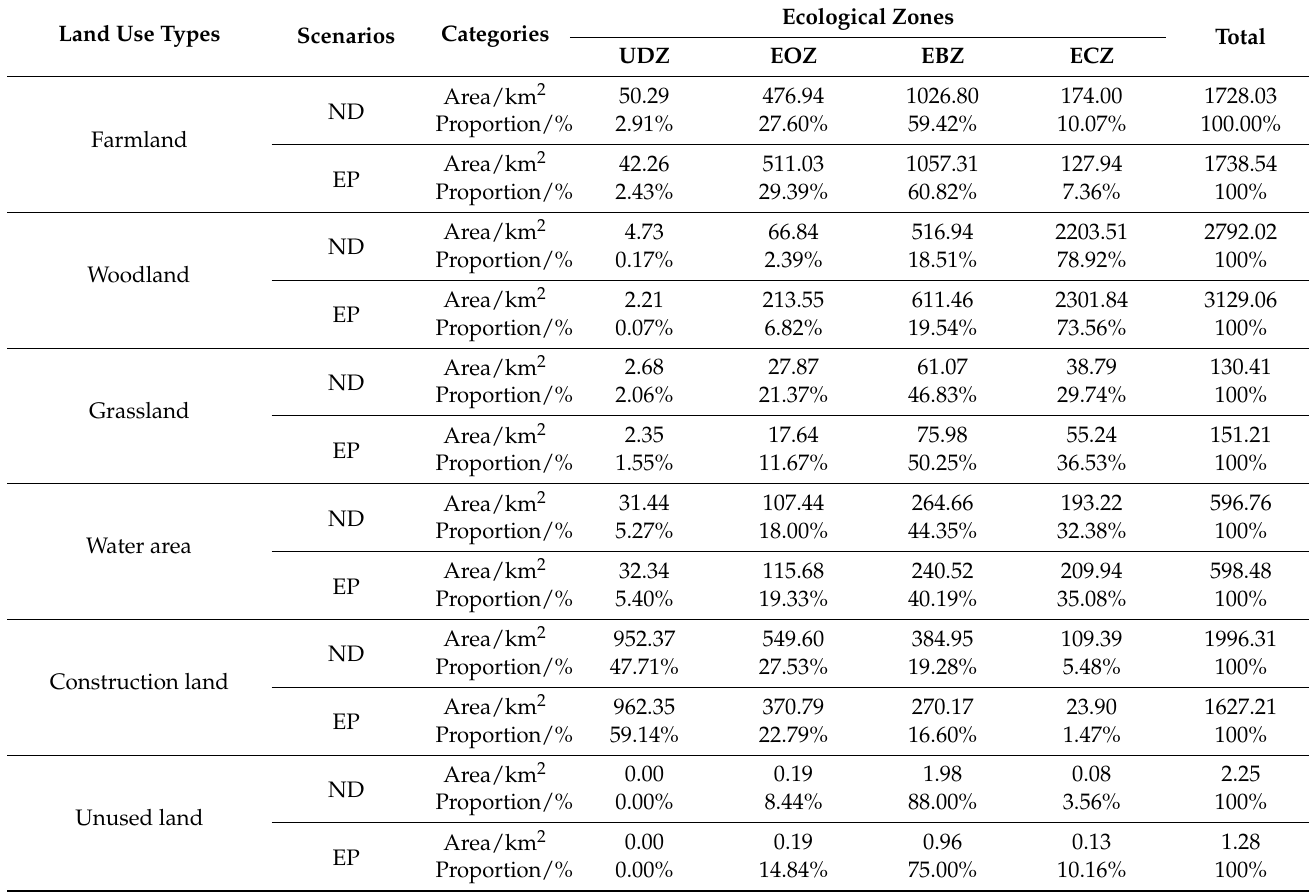
Table 5. Land use area and proportion in ecological